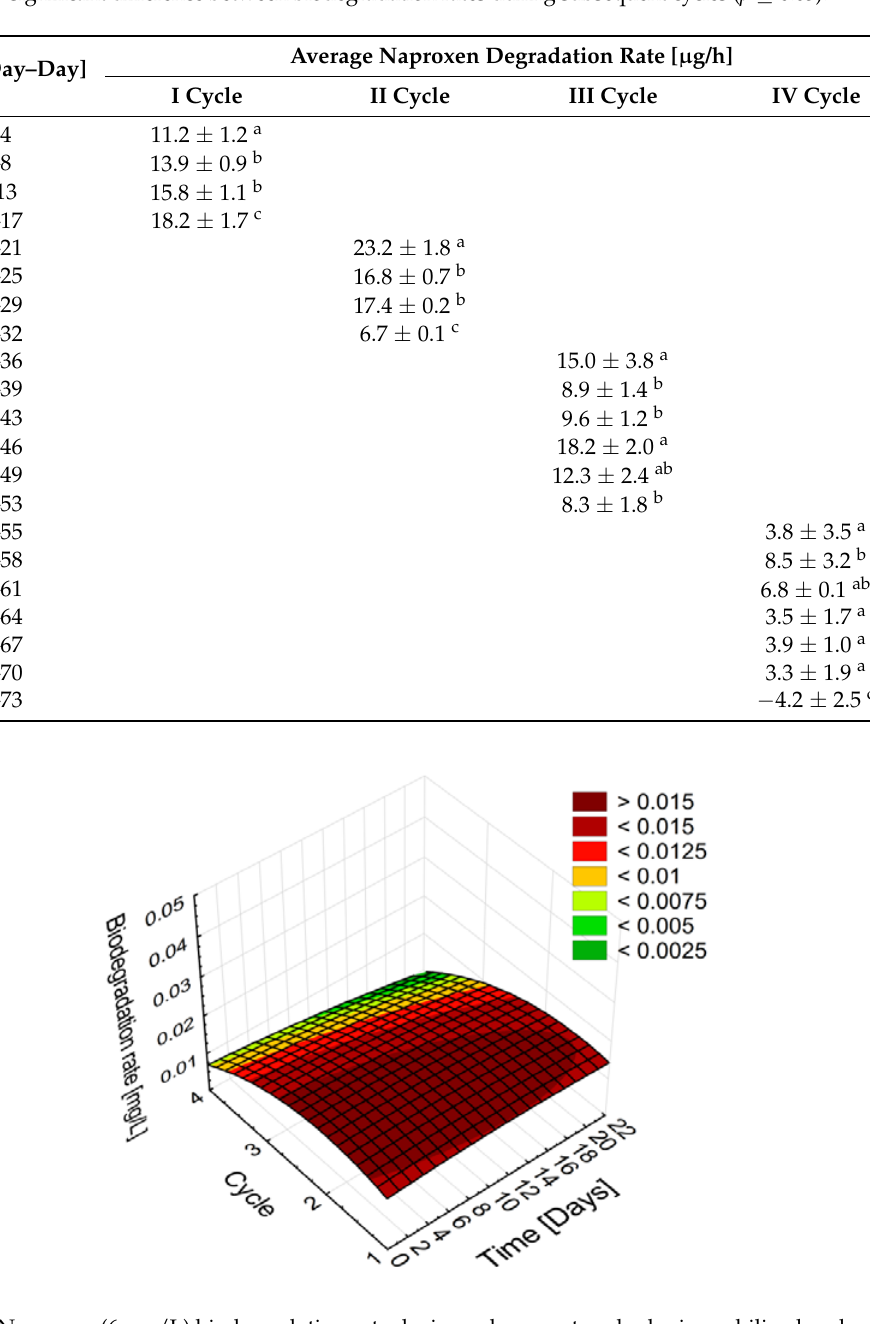
Table 3. Average biodegradation rate of 6 mg/L naproxen by immobilized cells of Planococcus sp. S5 in each cycle. Data presented as a mean ± standard deviation of three replicates. Different letters (a, b, c) indicate a statistically significant difference between biodegradation rates during subsequent cycles ( p ≥ 0.05).